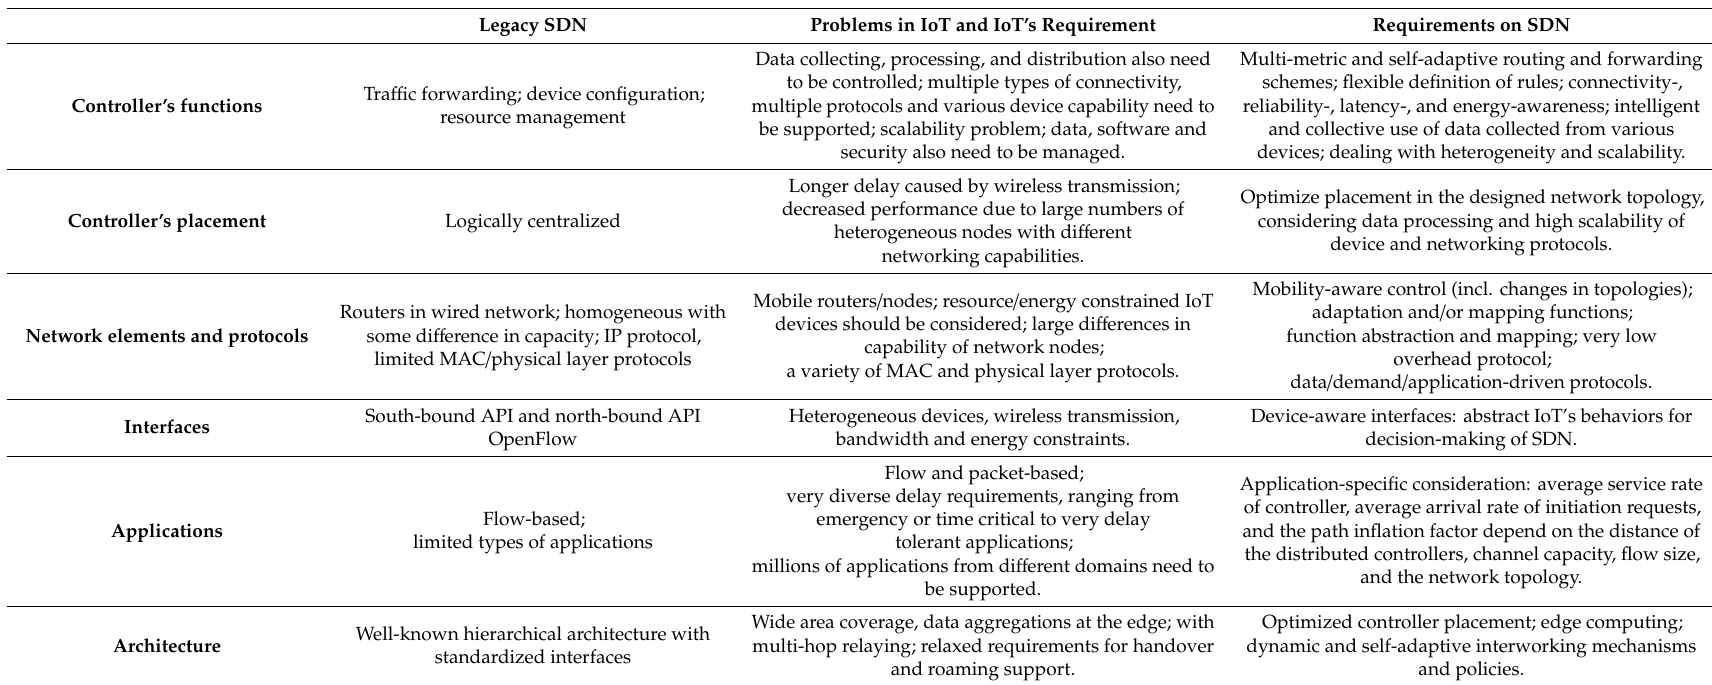
Table 3. Requirements on SDN driven by